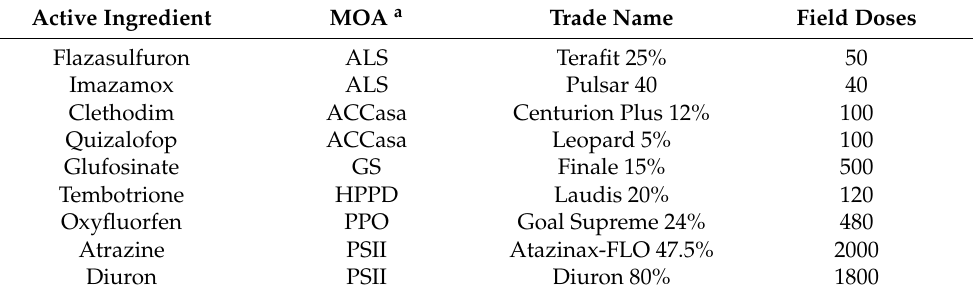
Table 1. Alternative herbicides (active ingredients), mode of action (MOA), trade name, and field doses (g ai ha − 1 ) evaluated to control susceptible and resistant Eleusine indica populations from